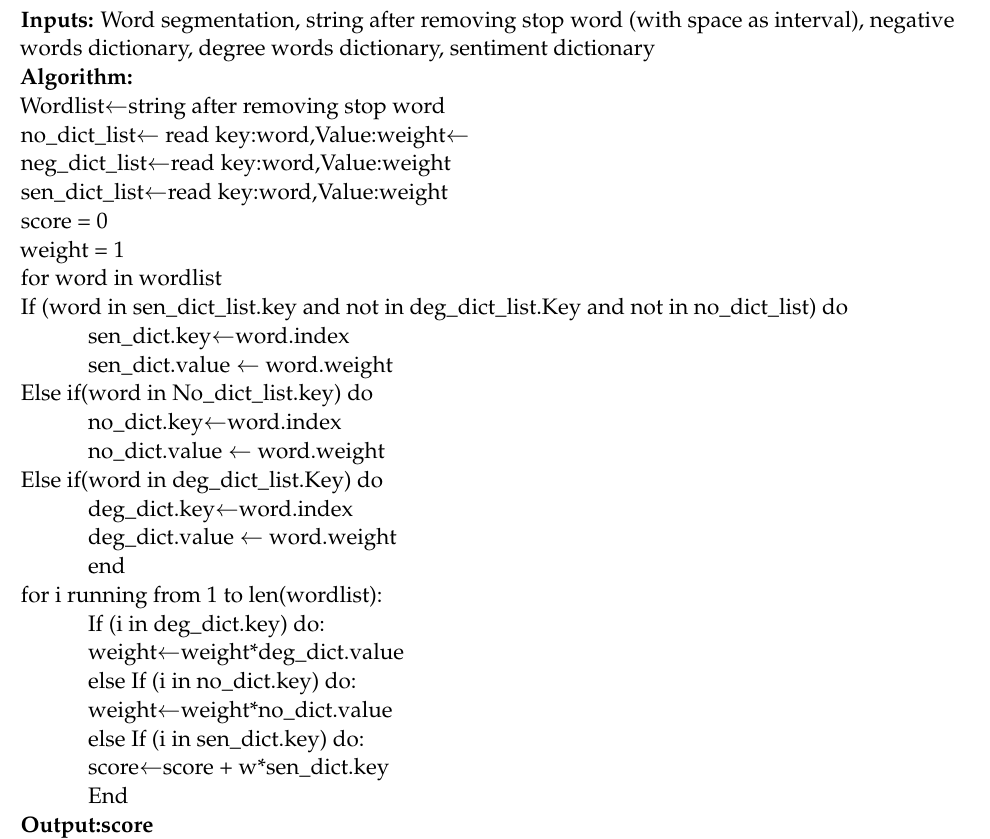
Algorithm 1: Calculating Sentimental Value of